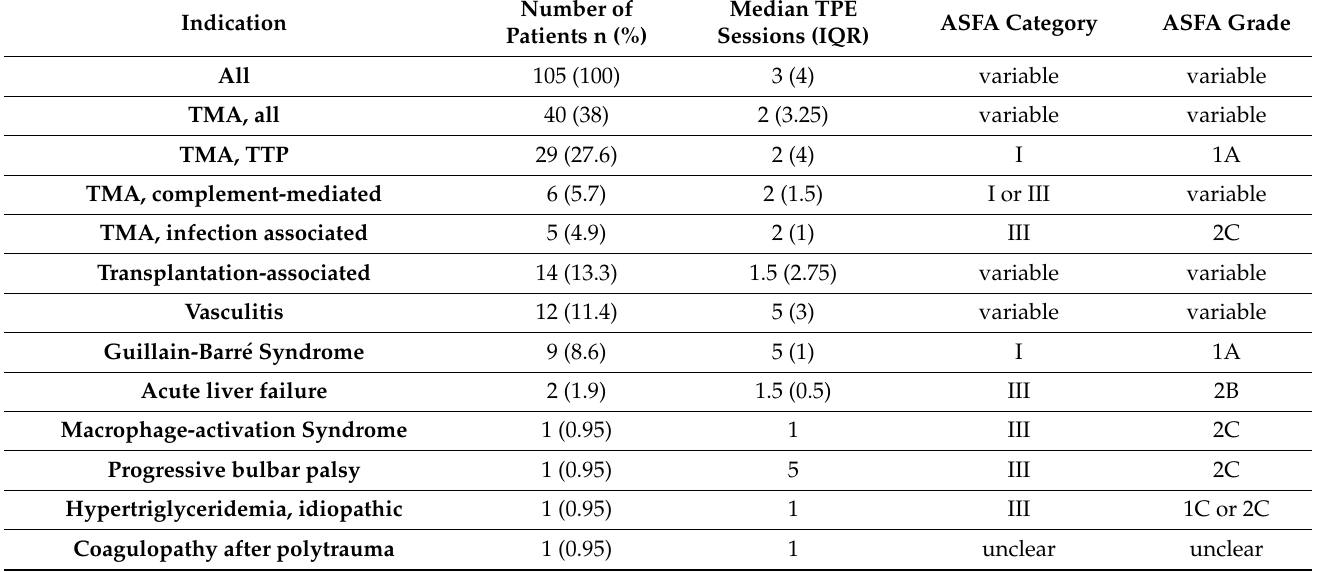
Table 2. Data are shown as patients per category and percentage, as well as median TPE sessions